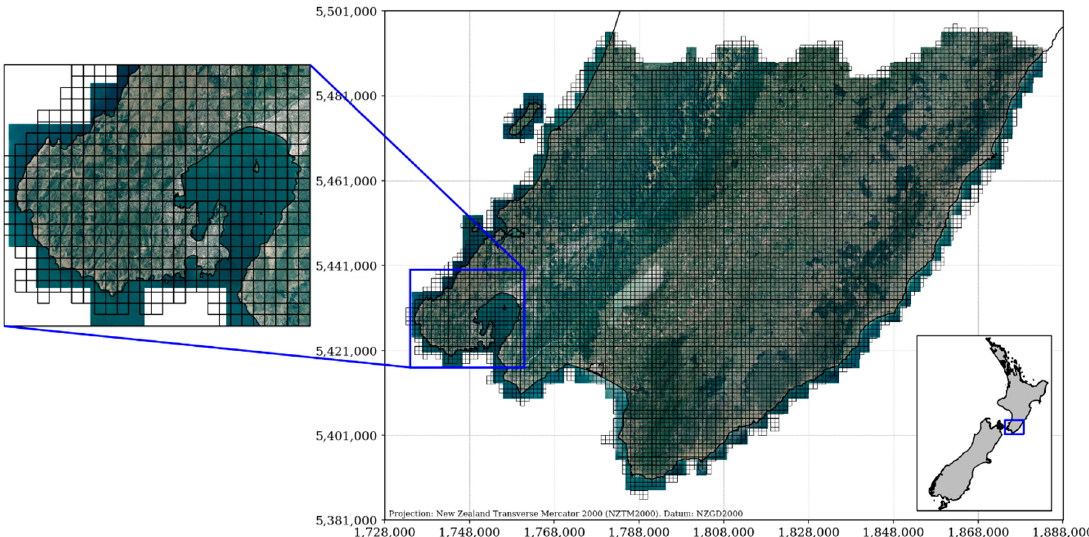
Figure 2. The Wellington Region of New Zealand and the mosaic of aerial photographs taken during the LiDAR survey in 2013 and 2014. The LiDAR data is subdivided into an equally-spaced grid of 9480 tiles with a 1 × 1 km spacing (outlined in black). Map projection is New Zealand Transverse Mercator (NZTM).